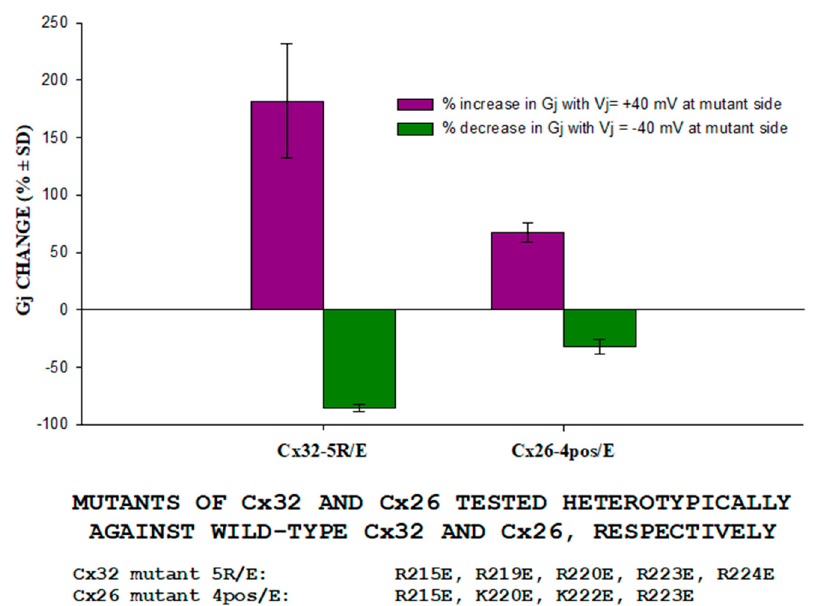
Figure 9. Percent Gj change in oocytes expressing Cx32-mutant (Cx32-5R/E) or Cx26-mutant (Cx26/4pos-E) heterotypic channels. Cx26-4pos/E channels behaved as Cx32-5R/E (or tandem-32) channels when subjected to Vj gradients, in spite of the fact that their fast Vj gates are activated by opposite Vj polarities (Cx32 is “negative gater”, Cx26 is “positive gater”). This confirms that the slow Gj change with Vj gradients is a gating behavior based on the activity of the chemical/slow gate, which is clearly distinct from that of the fast Vj gate1]. Adapted from [1].